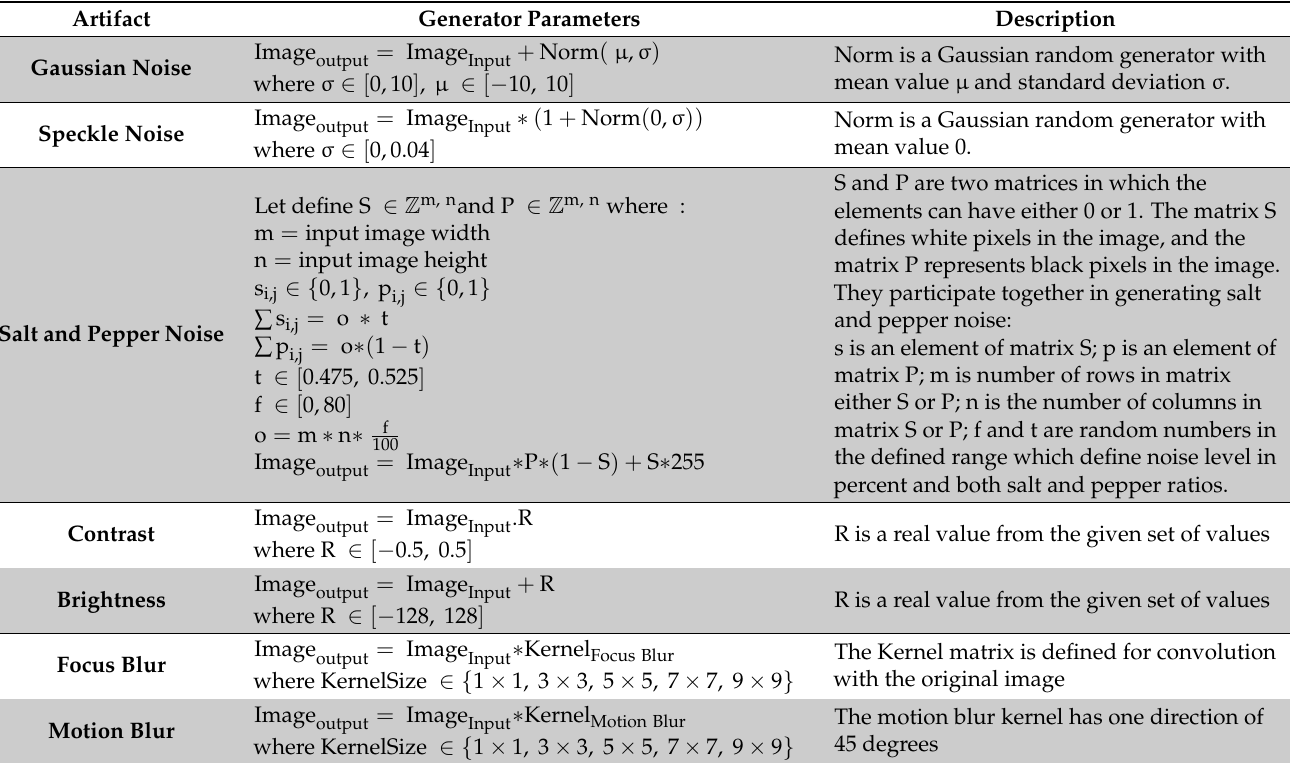
Table 1. Different parameter settings for our three different datasets generating